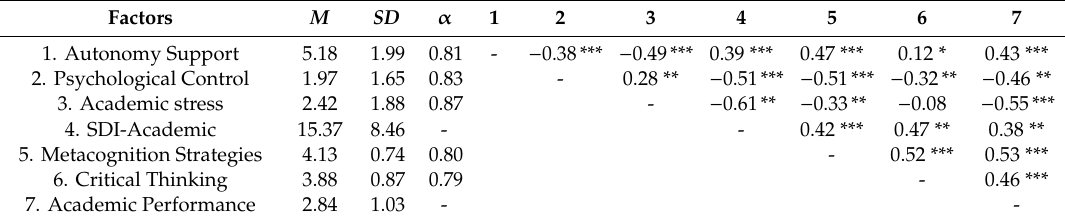
Table 2. Descriptive statistics and correlations between all